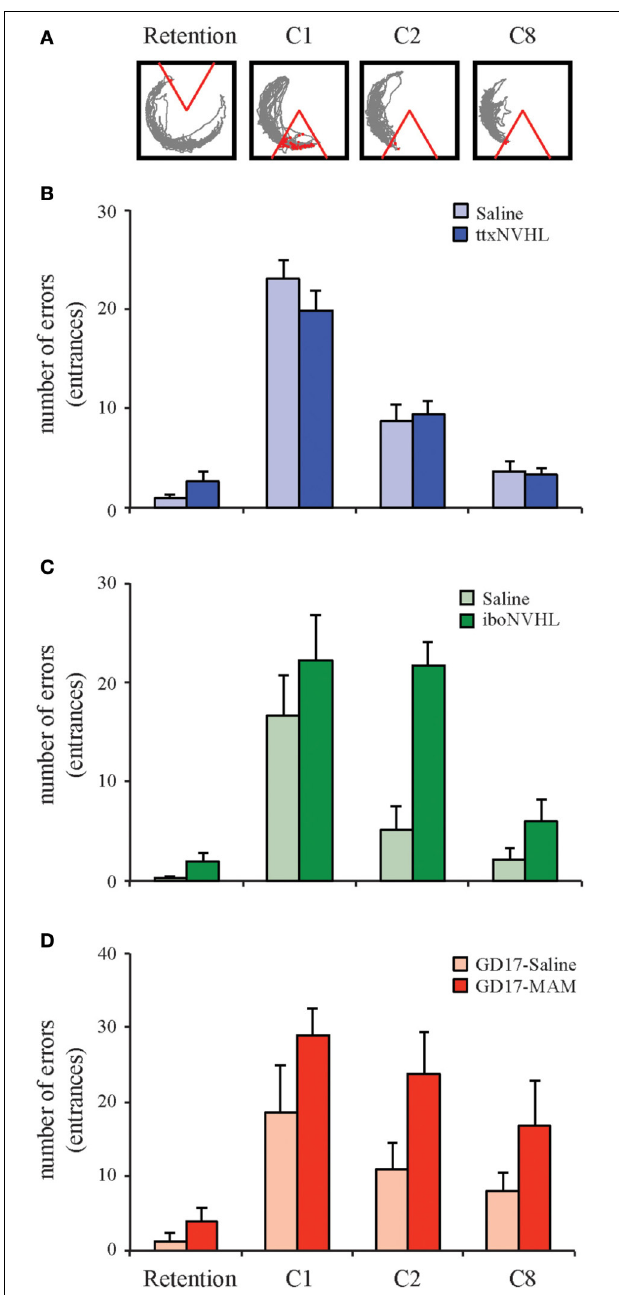
FIGURE 4 | Cognitive flexibility is differently altered by neurodevelopmental insults. Active place avoidance can be used to test cognitive flexibility. (A) One day after training to the initial shock zone, the animals are tested in a retention trial and eight trials in which the shock zone is shifted 180 ◦ from the initial location. The ability to adapt to the conflict between the shifted shock zone location and the memory of the initial shock zone location was measured as the number of entries into the shifted shock zone location (errors). (B) Cognitive flexibility is normal in ttxNVHL animals. (C,D) As indicated by the retention trial, both the iboNVHL and GD17-MAM rats are capable of performing the active place avoidance task after 2 or 4 days of training, respectively. However, cognitive flexibility during the 180 ◦ conflict trials is disrupted in iboNVHL and GD17-MAM animals. Data are presented as average ±